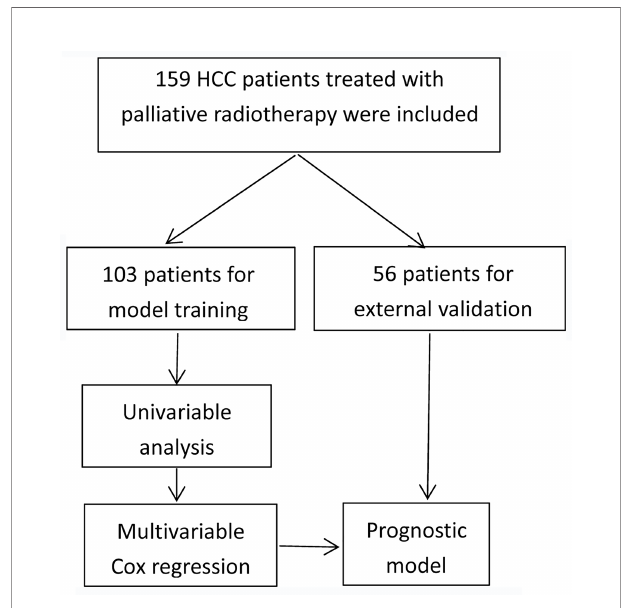
FIGURE 1 | Flowchart of patients